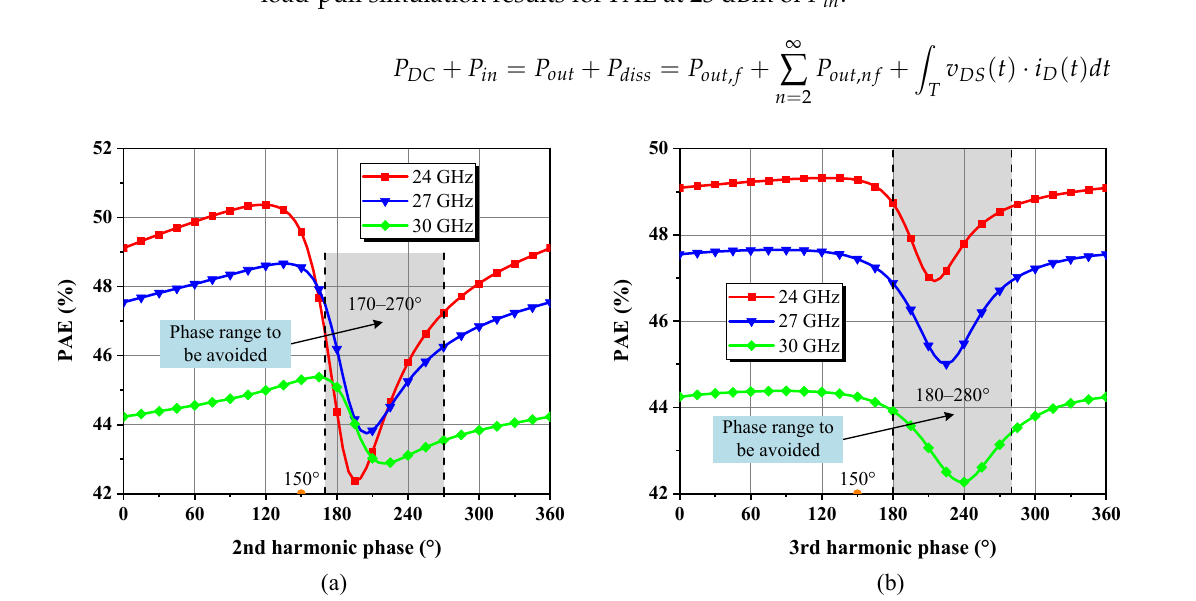
Figure 5. Influence of the ( a ) second and ( b ) third harmonic phases on simulated PAE at different frequencies for a constant 0.95 magnitude of load reflection coefficient when given 23 dBm of available P in .